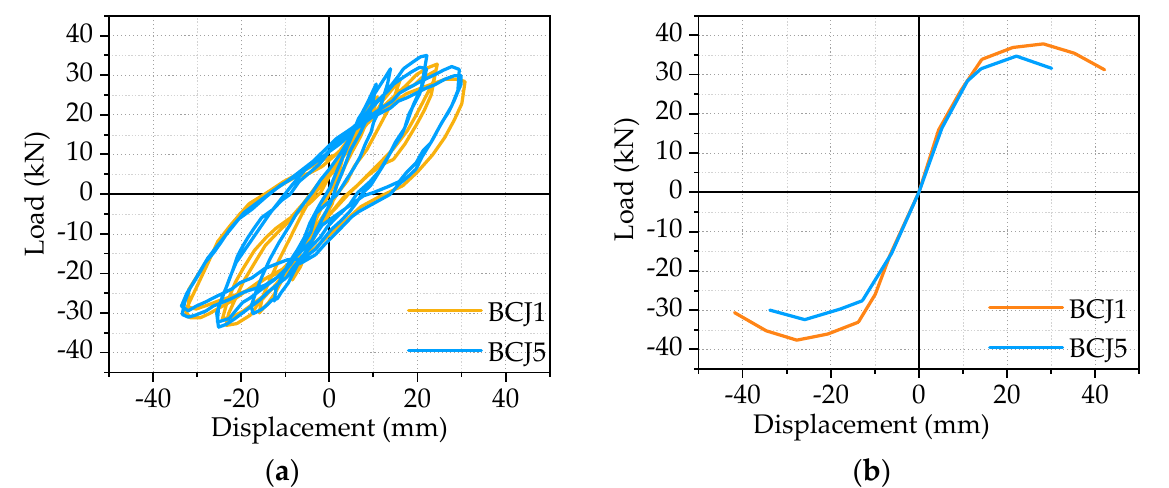
Figure 11. The effect of stirrup ratios in the core area: ( a ) Hysteretic curve; ( b ) Skeleton curve.